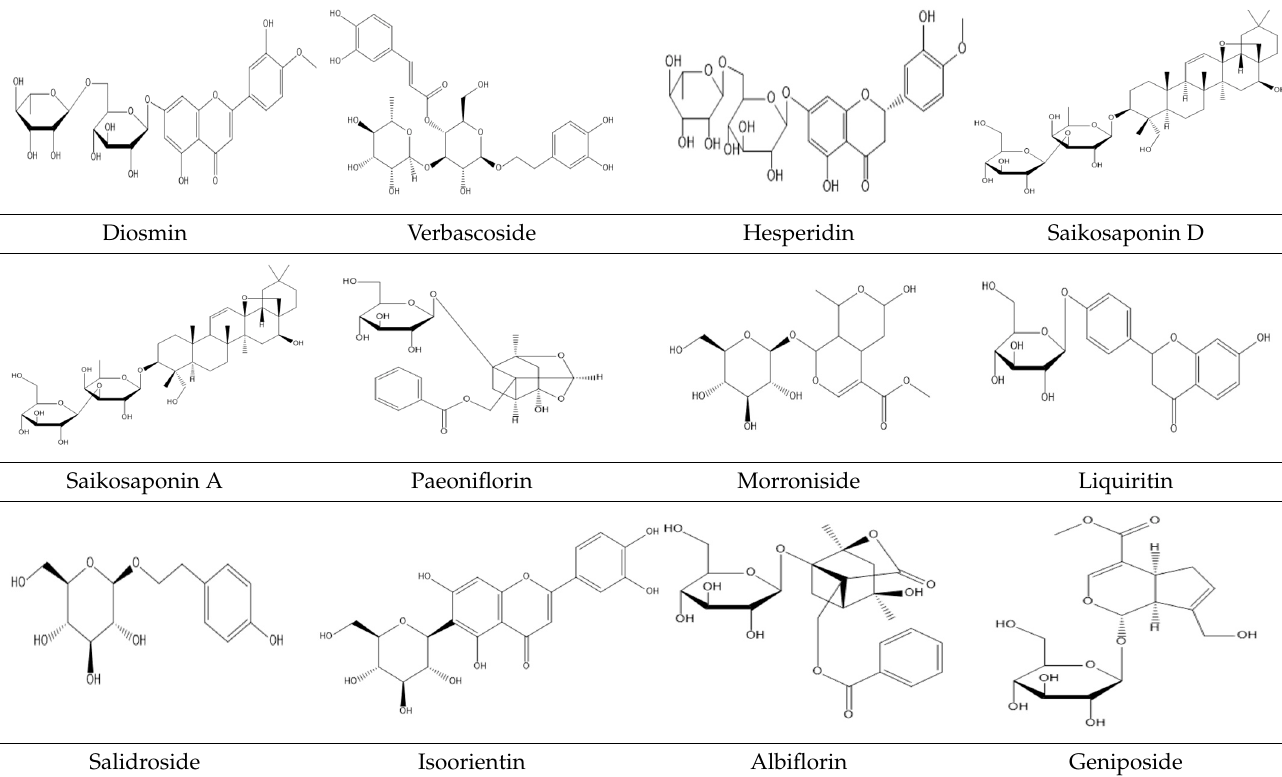
Table 2. Structure of several glycosides.